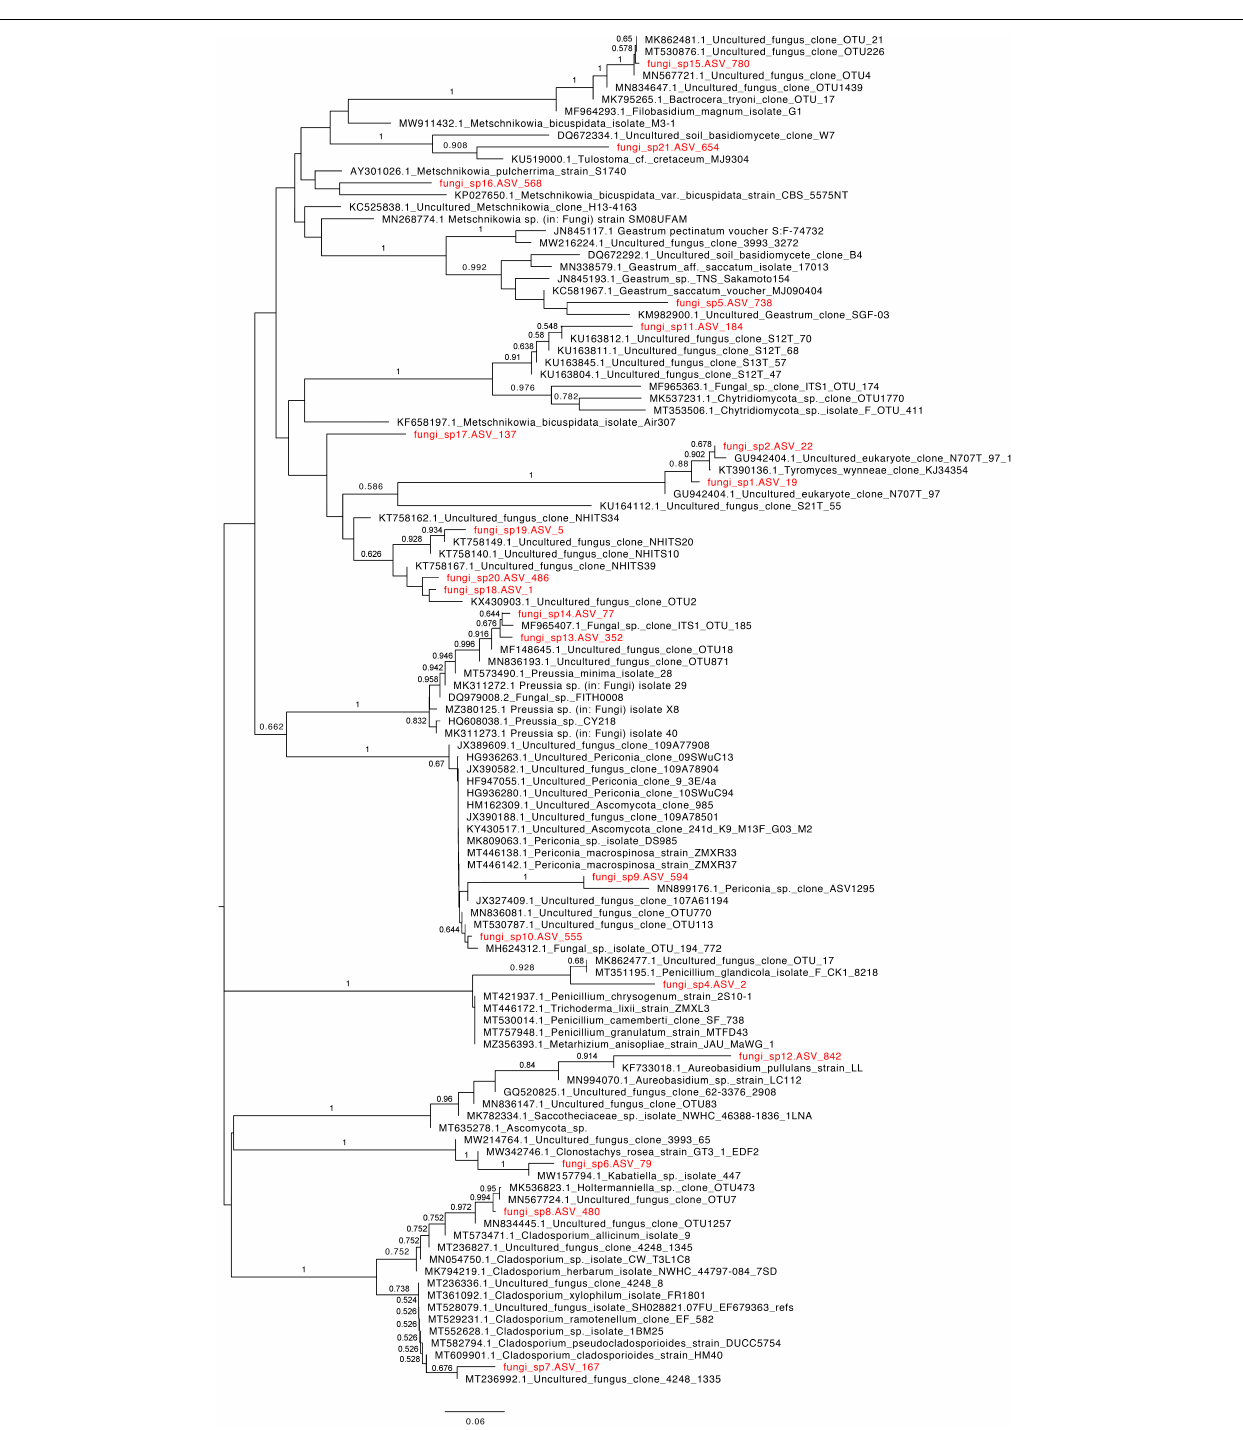
(Nagano and Nagahama, 2012). The present work represents the first report addressing this knowledge gap for three